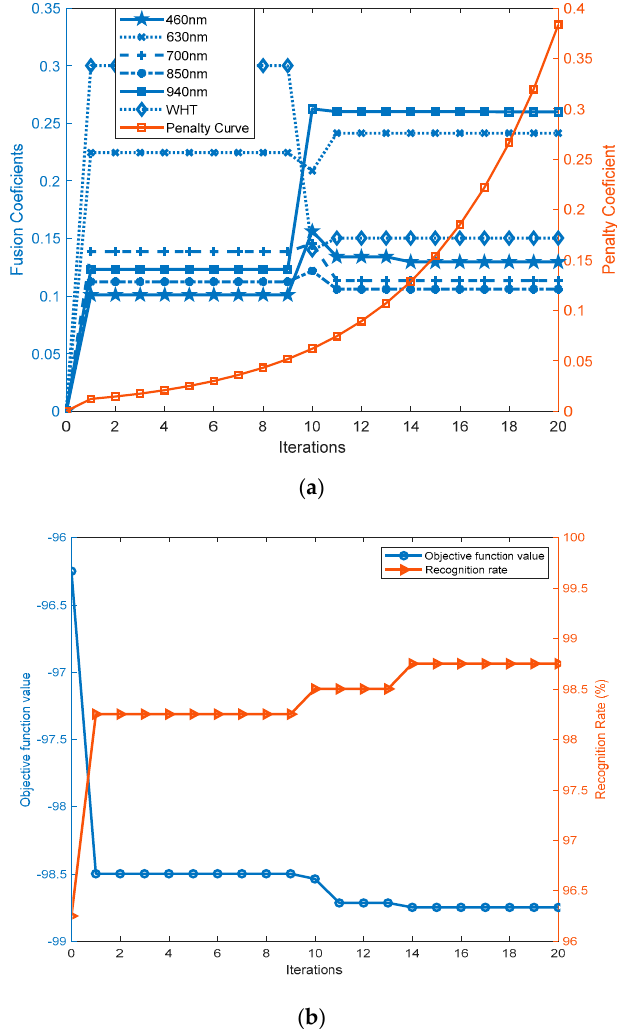
Figure 12. The fusion parameter searching processes. ( a ) Curves of the fusion parameters and penalty parameter, ( b ) Curves of the objective function value and recognition rate.